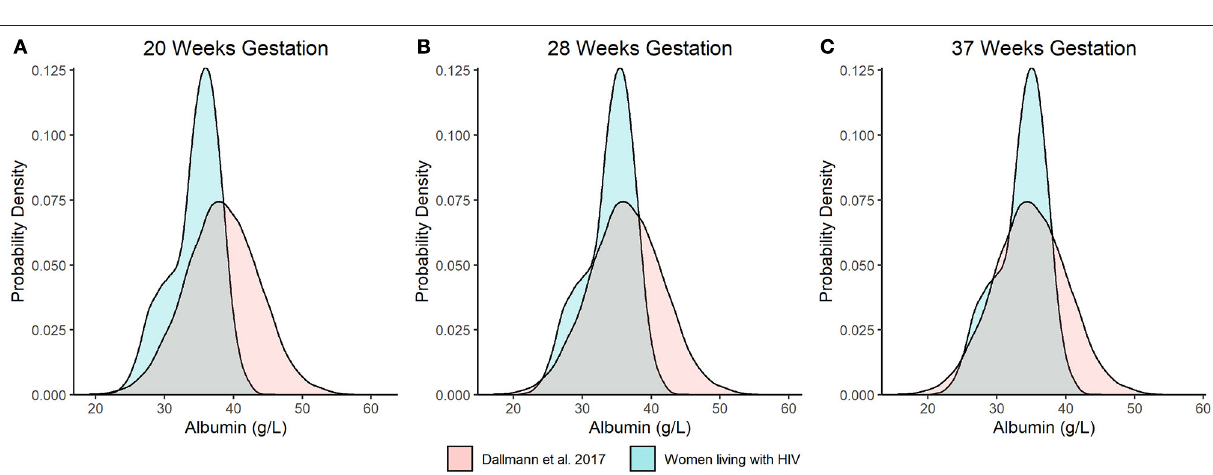
AAG concentrations rapidly declined until reaching a nadir of 70.1 mg/dL at ∼ 7 wks